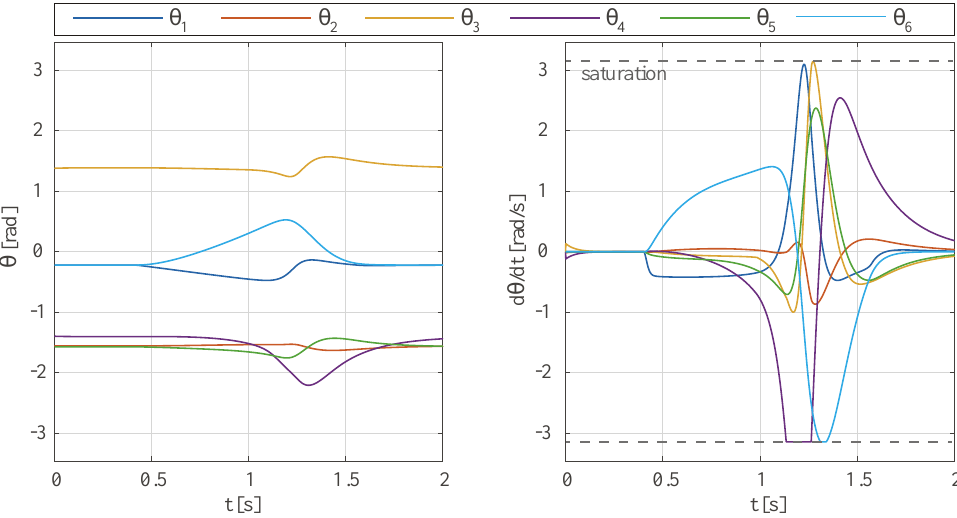
Figure 8. Joint rotations and speeds for the motion shown in Figure